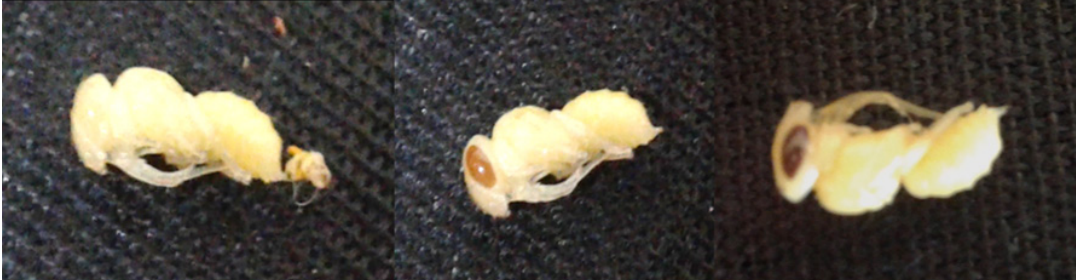
Fig 3. Pupae of Ceratina binghami at different stages of eye